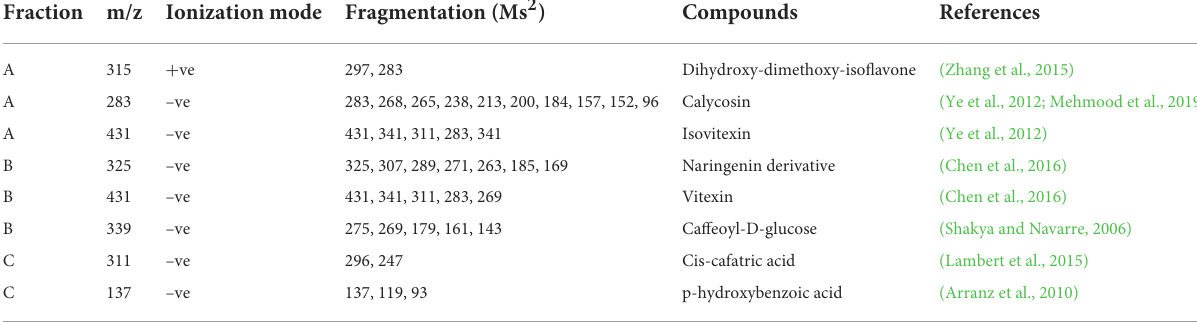
TABLE 1 Identification of flavonoids, phenols and carbohydrates in HPLC Fractions of GW strain. Fraction m/z Ionization mode Fragmentation (Ms 2 )